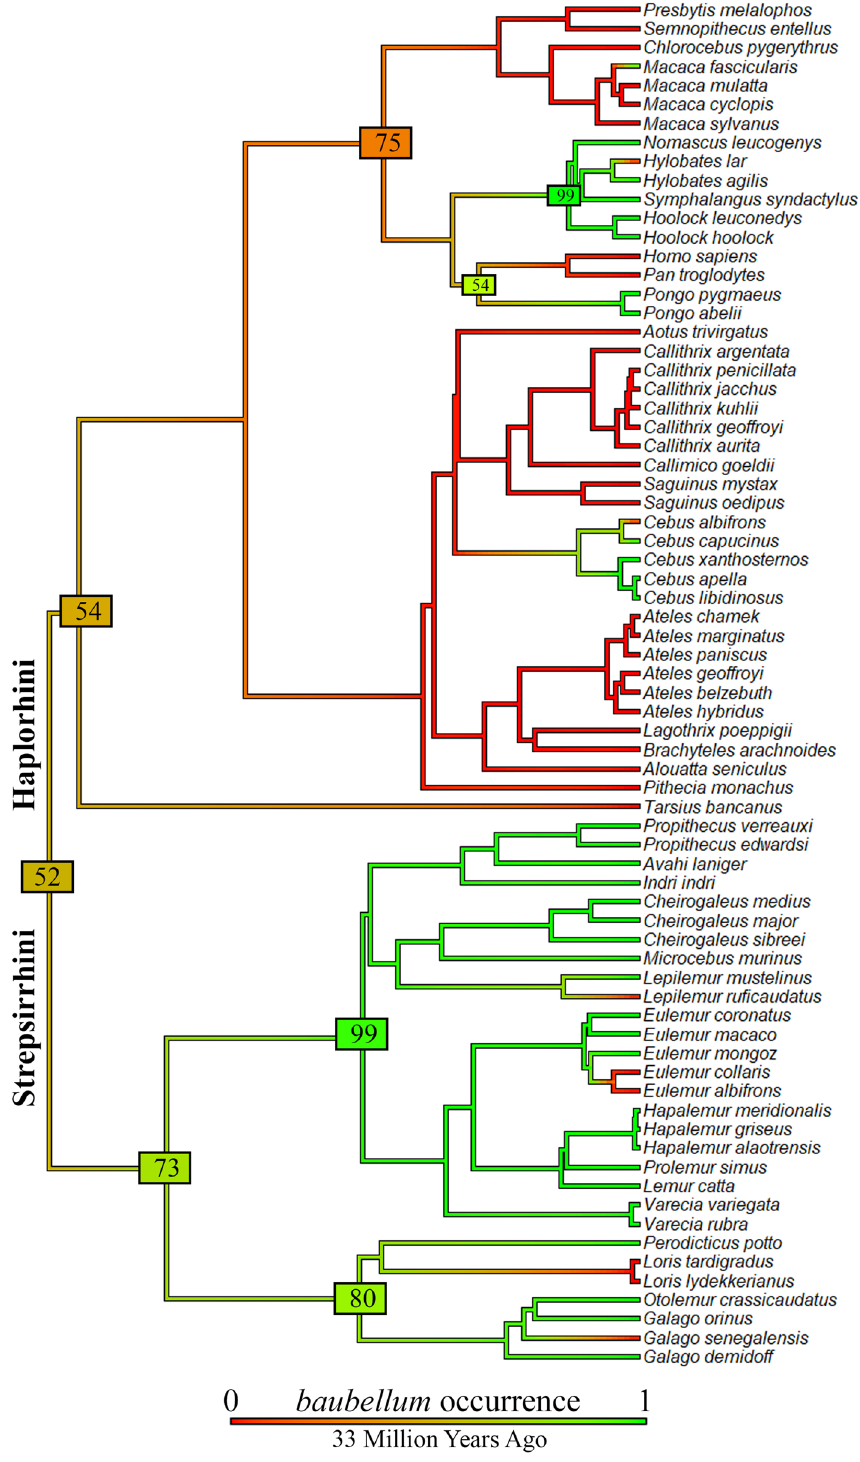
Figure 3. Ancestral character state reconstruction of baubellum excluding outgroups. Results from 1000 stochastic character maps (where the character analyzed is the baubellum occurrence) displayed in aggregate (outgroups were excluded). The colour of edges in the tree gives the posterior probability (computed as the relative frequency across stochastic maps) of each baubellum state through the history of the clade. Green indicates a high posterior probability of baubellum presence and numbers in green (or light green) boxes indicate the proportion of iterations that mapped baubellum presence to those particular branches. The length of the legend also gives a scale for the branch tree length, (in this case in Millions of Years Ago). Phylogeny by Springer 71 , dropped. Figure generated in R (v. 4.0.3, https:// www.R- proje ct. org/) 114